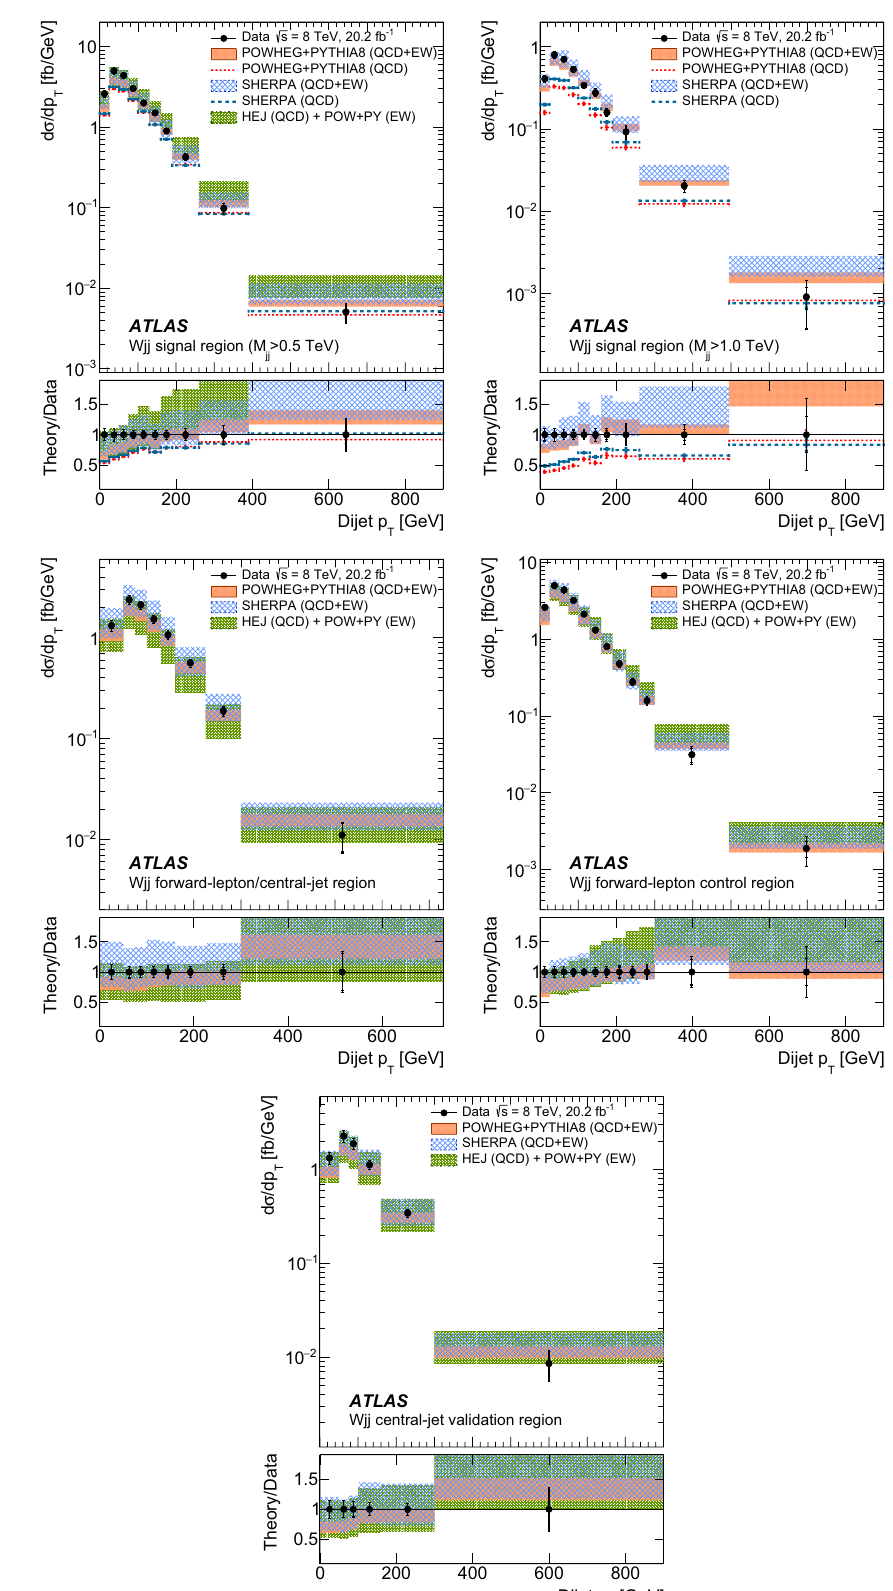
Fig. 45 Differential W jj production cross sections as a function of dijet p T in the signal, high-mass signal, forward-lepton/central-jet, forward-lepton, and central-jet fiducial regions. Both statistical ( inner bar ) and total ( outer bar ) measurement uncertainties are shown, as well as ratios of the theoretical predictions to the data (the bottom panel in each